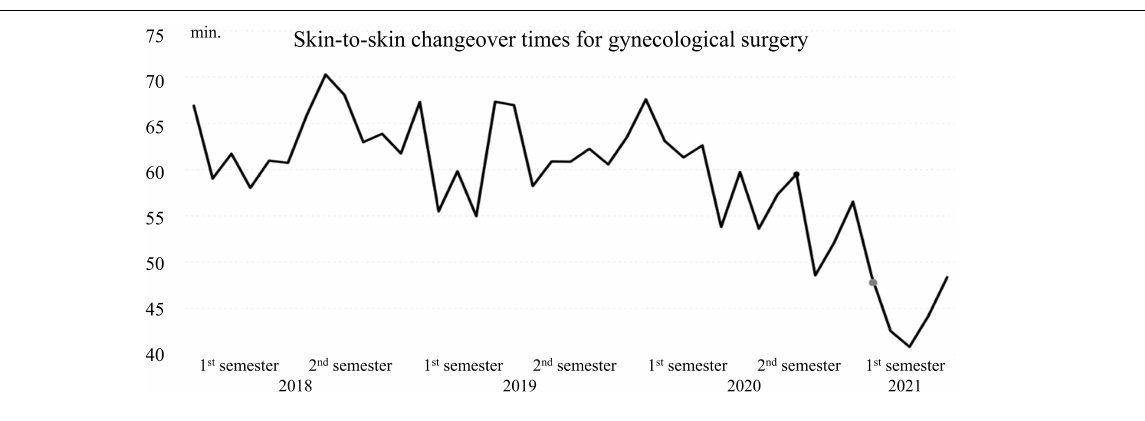
FIGURE 4 | Mean changeover time (min.) per month from January 2018 to May 2021 for gynecological